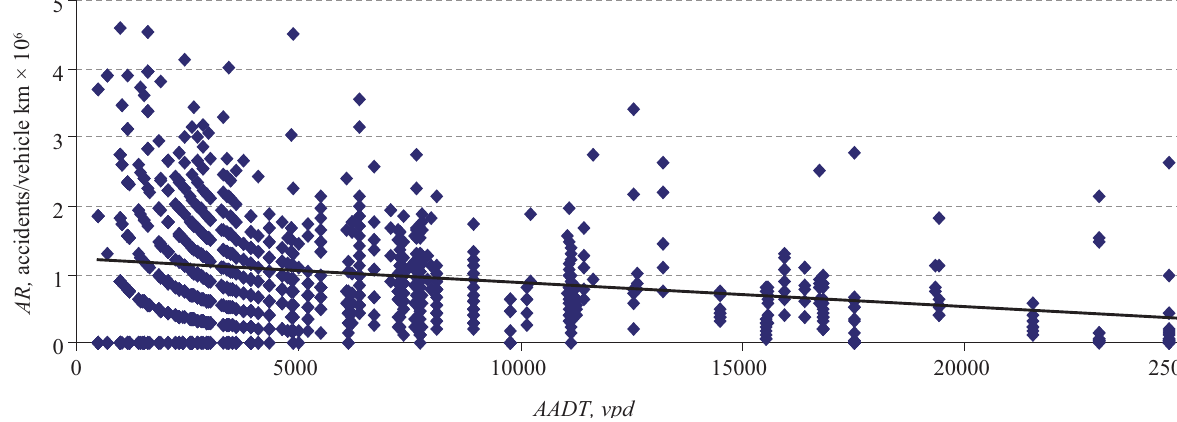
Fig. 1. Relation between traffic volume and AR on state main roads